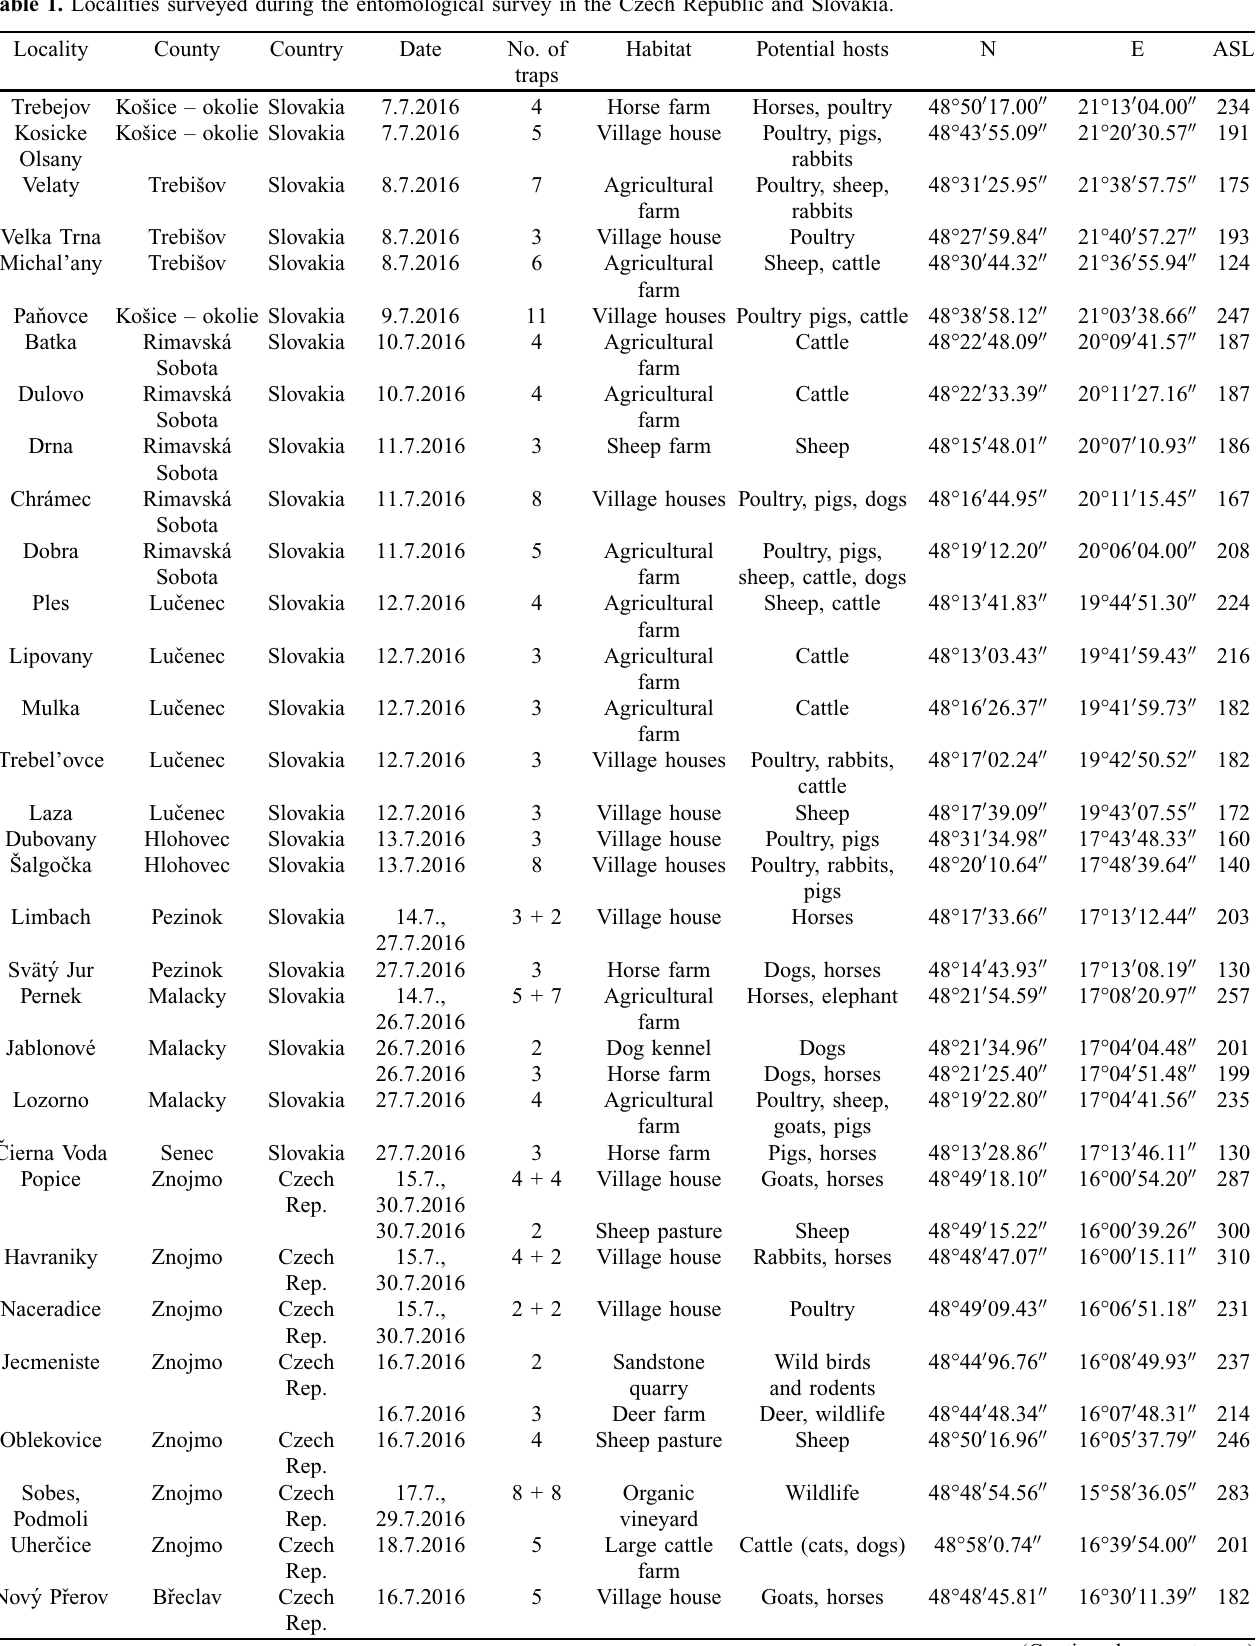
Table 1. Localities surveyed during the entomological survey in the Czech Republic and Slovakia.